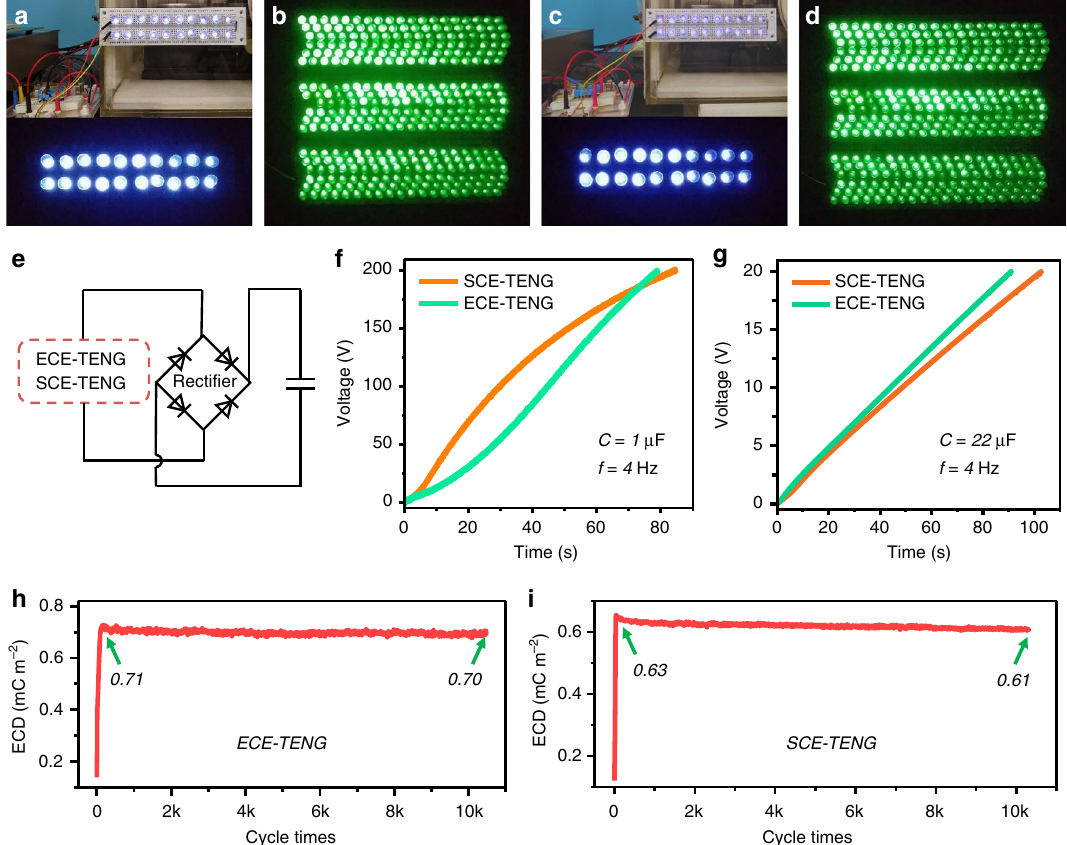
Fig. 5 Application of charge excitation nanogenerator to drive devices. a The external charge excitation triboelectric nanogenerator (ECE-TENG) lights up 20 white LEDS with diameter of 10 mm in bright and dark environments, and b 340 green LEDS with diameter of 5 mm in dark environment. c The self- charge excitation triboelectric nanogenerator (SCE-TENG) lights up 20 white LEDS with diameter of 10 mm in bright and dark environments, and d 340 green LEDS with diameter of 5 mm in dark environment. e The circuit of charging the capacitors. f Charging curves of 1 μ F capacitor with ECE-TENG and SCE-TENG. g Charging curves of 22 μ F capacitor with ECE-TENG and SCE-TENG. Effective charge density of h ECE-TENG and i SCE-TENG with 10,000 operation